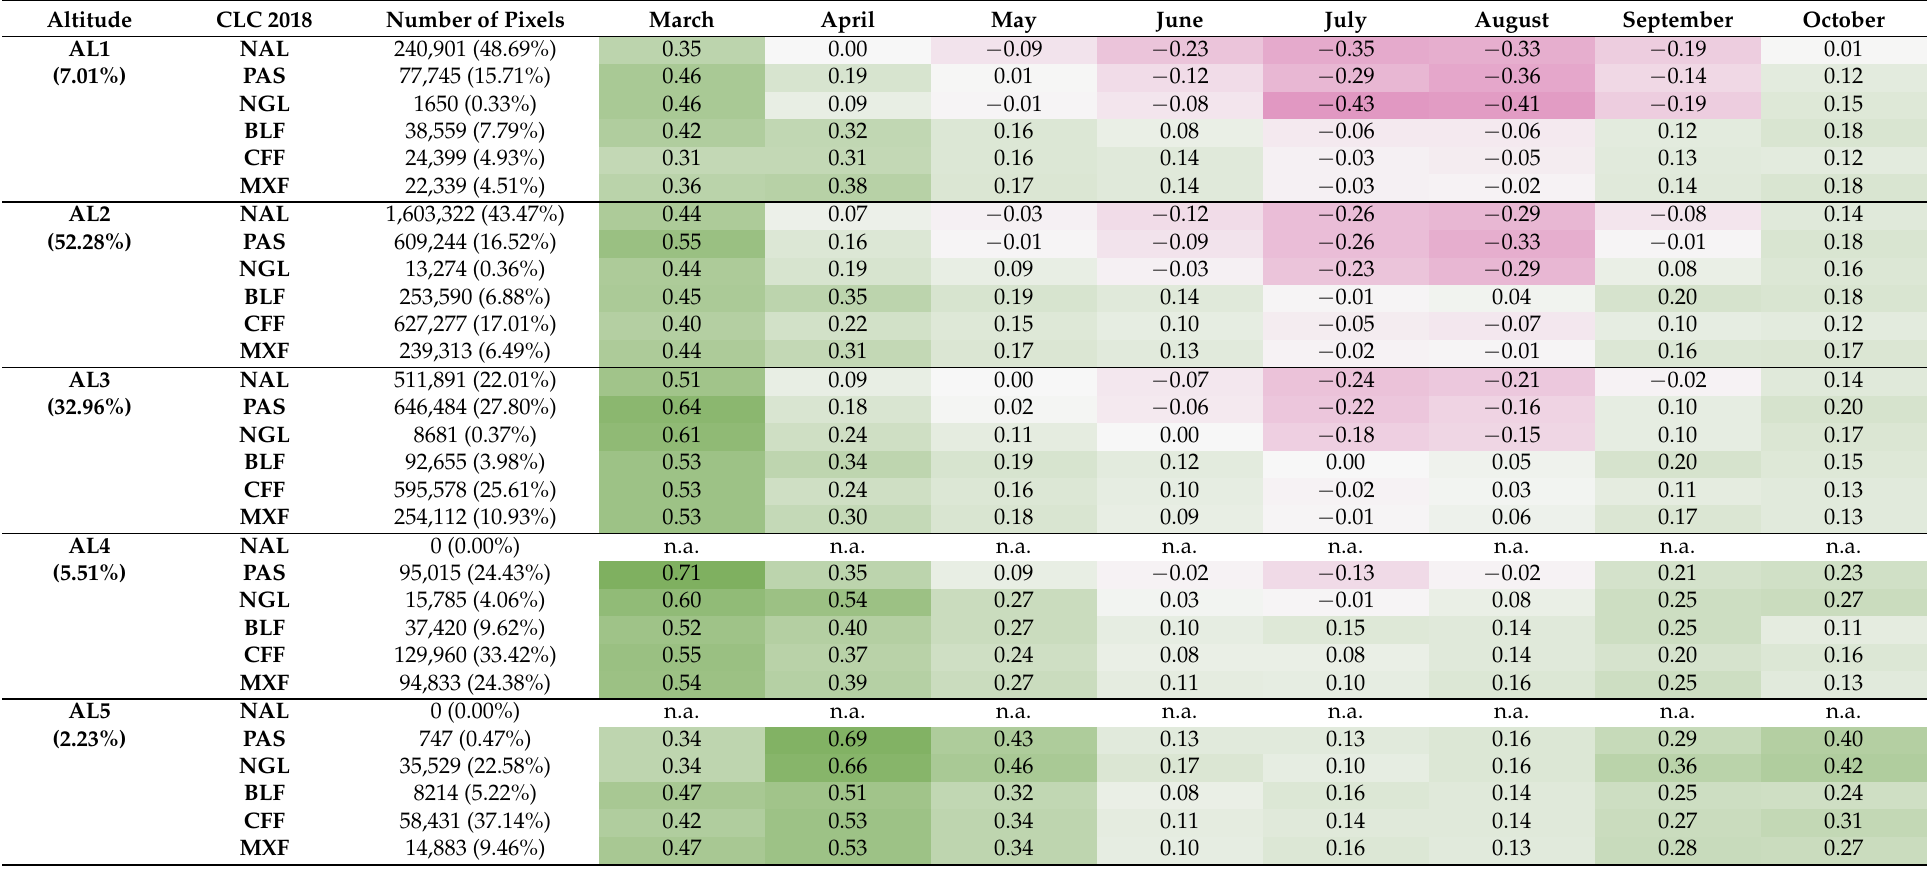
Table 4. Median pixel-based monthly correlation coefficients (Bravais-Pearson) between NDVI and LST in Bavaria from 2001 to 2020, by altitude and land cover classes. The percentage (in parentheses) of the respective altitude class indicates the area share of this class in the total area of Bavaria. The percentage of the respective land cover class indicates the area share of this land cover in the total area of the respective altitude class. The color-coding of the individual median values is based on Figure 3. Land cover classes according to CLC 2018 are non-irrigated arable land (NAL), pastures (PAS), broad-leaved forest (BLF), coniferous forest (CFF), mixed forest (MXF), and natural grasslands (NGL). Altitude levels are <300 m